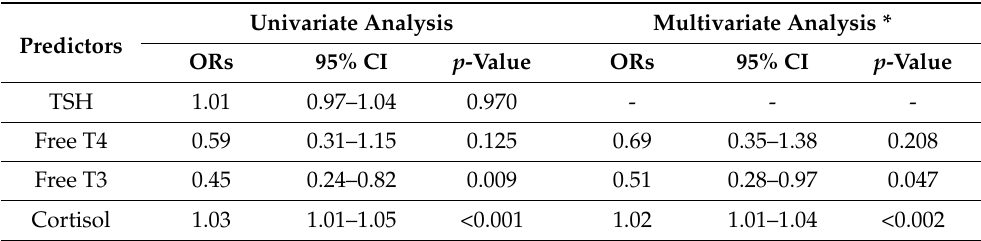
Table 2. Univariate and multivariate analysis of relationship of thyroid function tests and cortisol with ICU mortality.